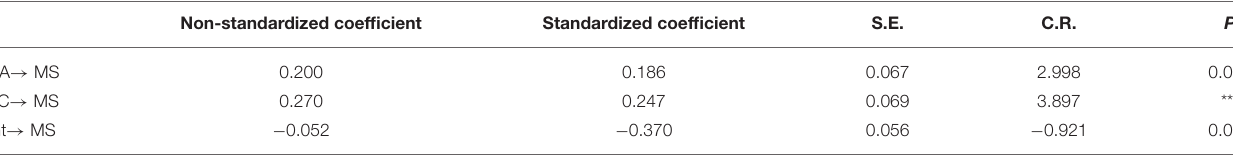
TABLE 7 | Moderating effect